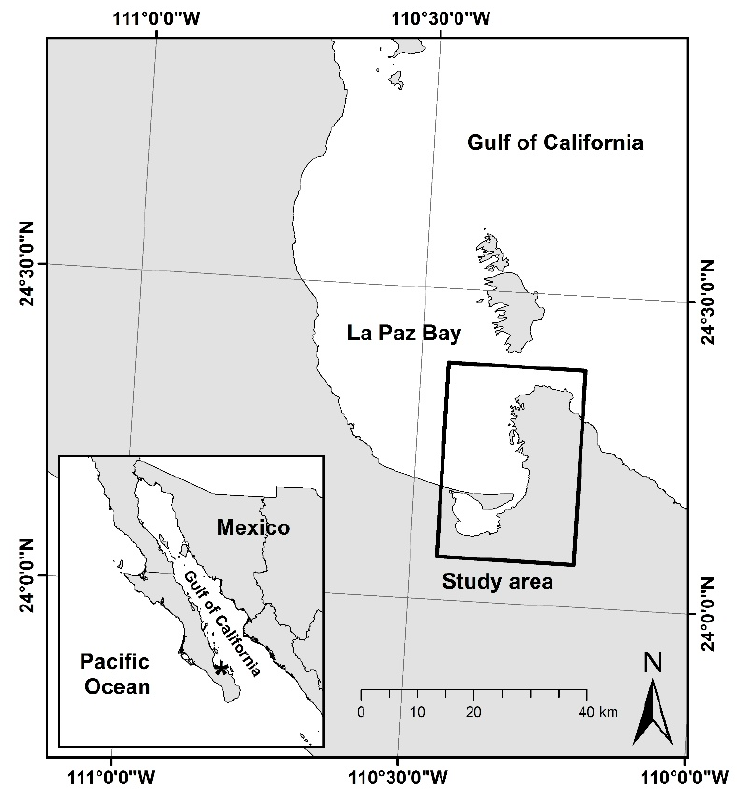
Figure 1. Study area location within La Paz Bay (southern Gulf of California).